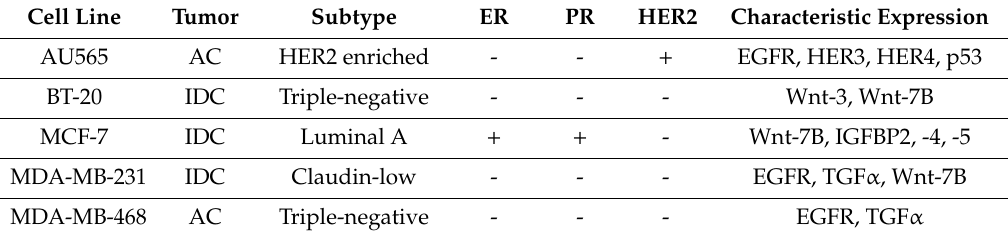
Table 1. Features of di ff erent breast cancer cell lines used in microgravity studies (modified from [41]). Cell Line Tumor Subtype ER PR HER2 Characteristic Expression AU565 AC HER2 enriched - - + EGFR, HER3, HER4, p53 BT-20 IDC Triple-negative - - - Wnt-3, Wnt-7B MCF-7 IDC Luminal A + + - Wnt-7B, IGFBP2, -4, -5 MDA-MB-231 IDC Claudin-low - - - EGFR, TGF α , Wnt-7B MDA-MB-468 AC Triple-negative - - - EGFR, TGF α AC, adenocarcinoma; EGFR, epidermal growth factor receptor; HER, human epidermal growth factor receptor; IDC, invasive ductal carcinoma; IGFBP, insulin-like growth factor-binding protein; TGF α , transforming growth factor